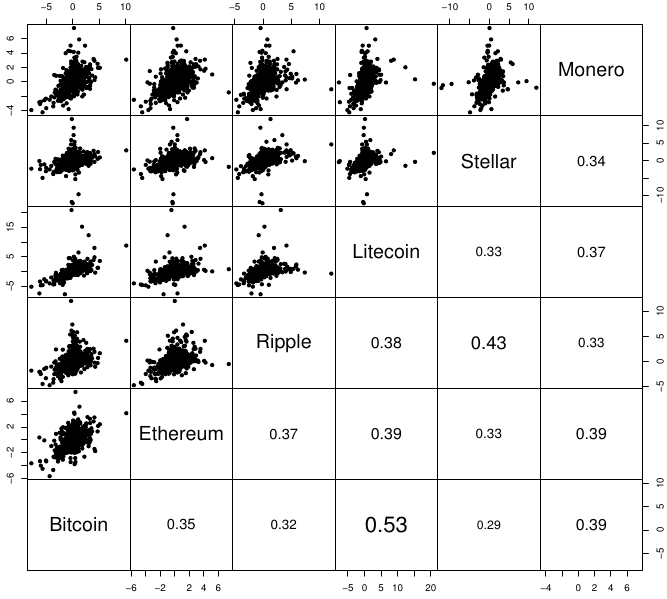
Figure 4. Scatter plots of the standardized residuals from the GARCH fits on the upper-left panel (above diagonal). The corresponding Kendall’s τ coefficients on the bottom-right